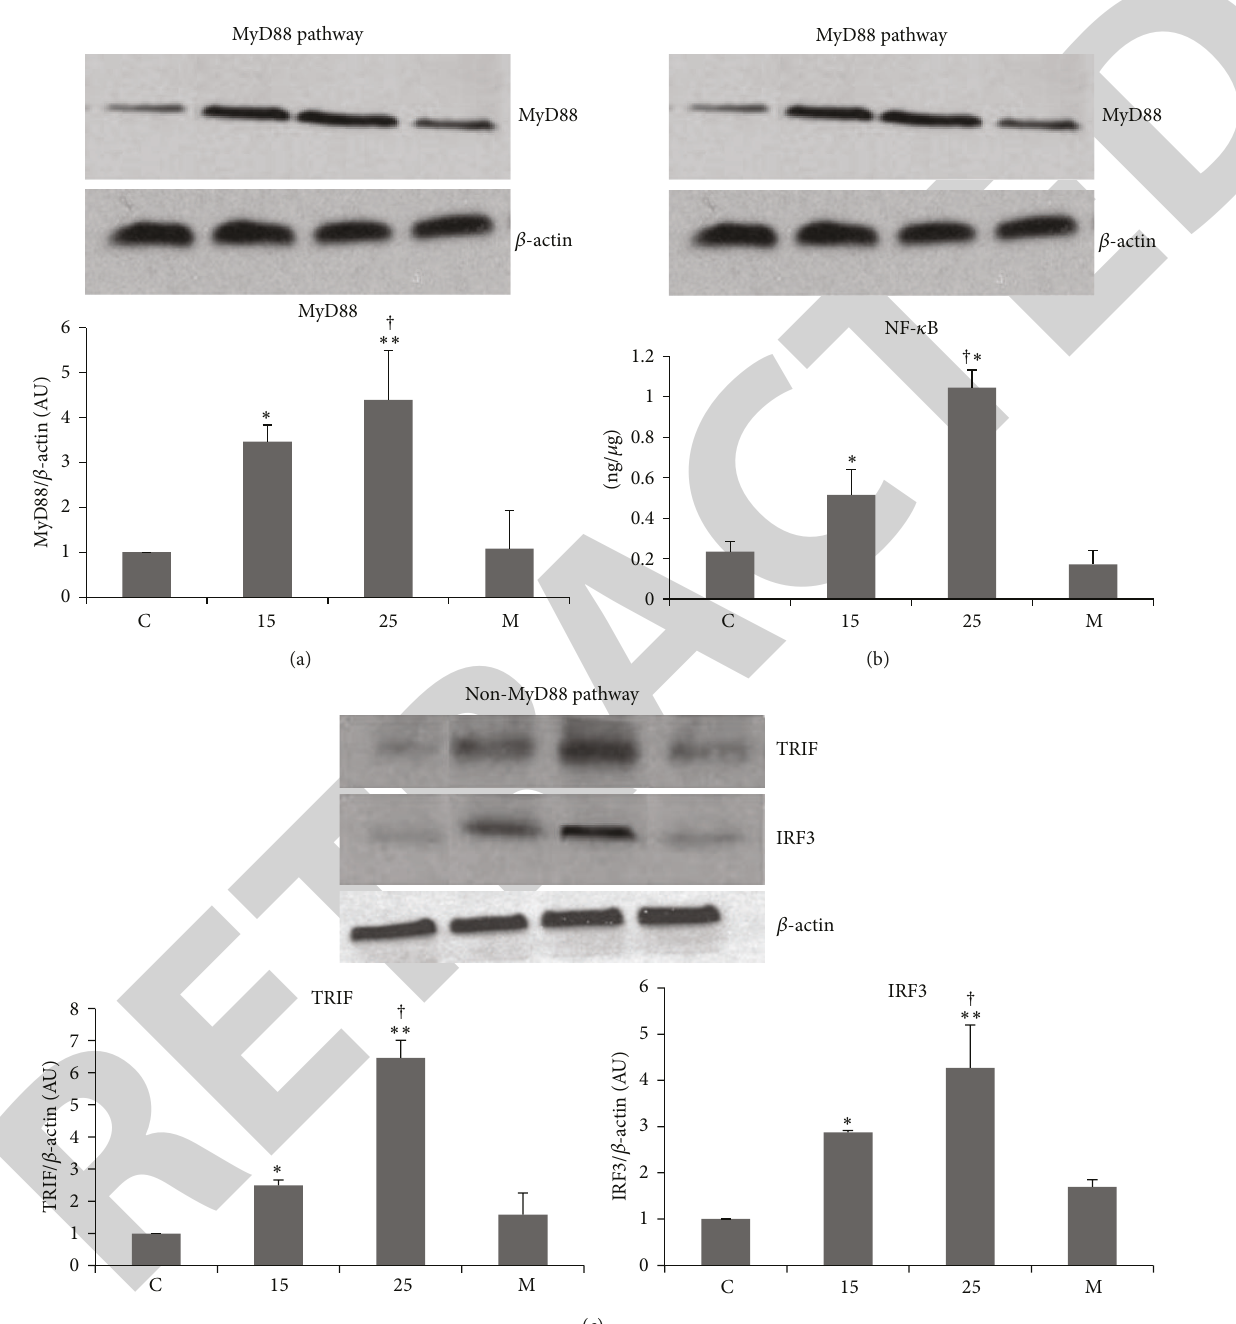
Figure 2: High glucose induces both MyD88 and Non-MyD88 pathways: HMVRECs were incubated and treated with 5.5, 15, and 25mM glucose and mannitol as described in Methods and legend of Figure 1 and protein lysates were harvested. (a) Western blots showing increased MyD88 protein levels normalized against 𝛽 -actin. ∗ 𝑃 < 0.01 versus control and ∗∗ 𝑃 < 0.001 versus control. † 𝑃 < 0.05 versus 15 mM, (b) increasednuclearp65levelswithHGtreatment. ∗ 𝑃 < 0.001 versuscontrol. † 𝑃 < 0.05 versus15mM,(c)representativeblotsshowingincreased TRIF and IRF3 protein levels with HG. Blots are normalized against 𝛽 -actin. TRIF: ∗ 𝑃 < 0.05 versus control; ∗∗ 𝑃 < 0.001 versus control; IRF3 ∗ 𝑃 < 0.01 versus control, ∗∗ 𝑃 < 0.001 versus control, and † 𝑃 < 0.05 versus 15